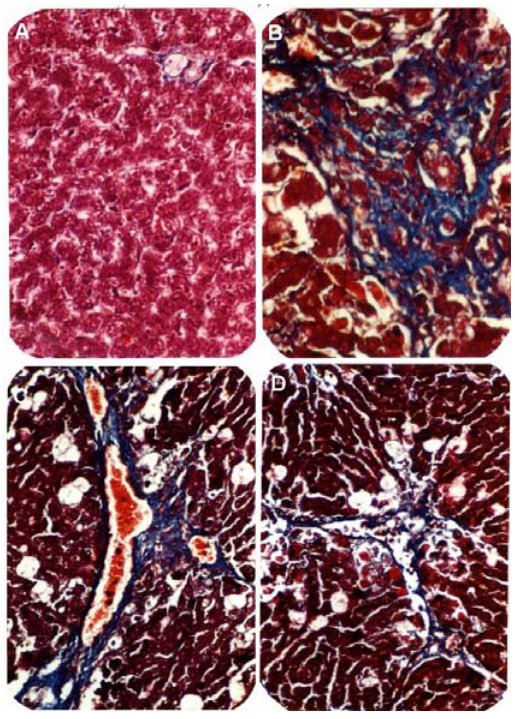
FIGURE 3. Section of liver stained with Masson trichrome stain showing collagen occurred as wavy fibrils either singly or fused together in dense bundles (A) control (normal) rat; (B) CCl 4 -treated rat: increased deposition of fibrous tissue; (C) CCl 4 + biphenyldimethyldicarboxylate (DDB) (375 mg/kg)-treated rat: moderate amount of fibrous tissue; (D) CCl 4 + DDB (75 mg/kg) + silymarin (22 mg/kg)-treated rat: mild deposition of fibrous tissue (Masson trichrome stain x 200).